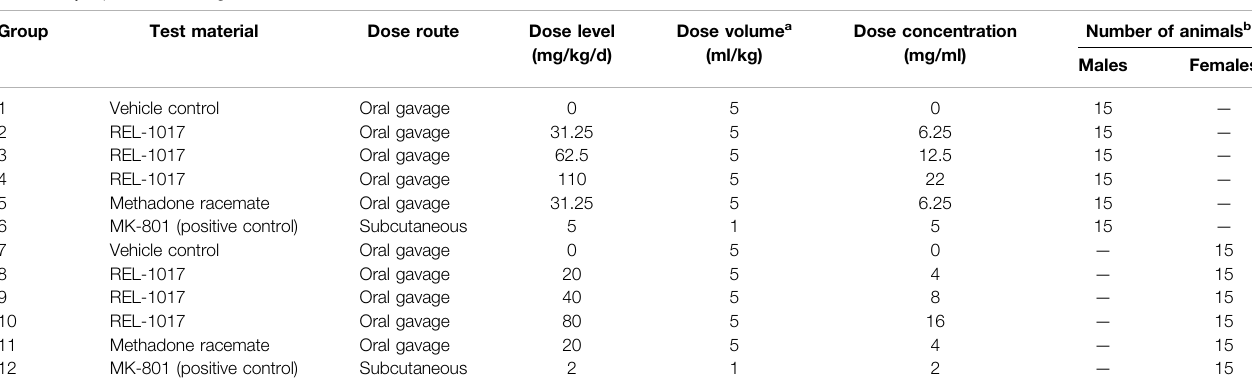
TABLE 1 | Experimental